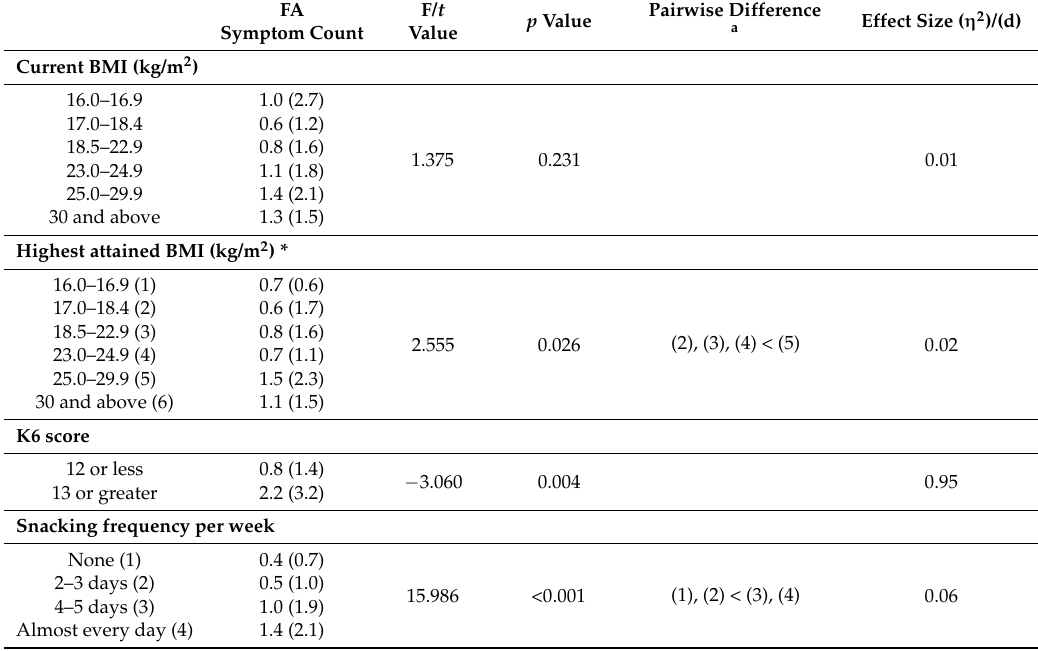
Table 4. Associations of body mass index (BMI), the Kessler Psychological Distress Scale (K6) score, and snacking frequency with the J-YFAS 2.0-diagnosed food addiction (FA) symptom count ( n = 731). FA F/ t Pairwise Difference 2 p Value a Effect Size ( η Symptom Count Value